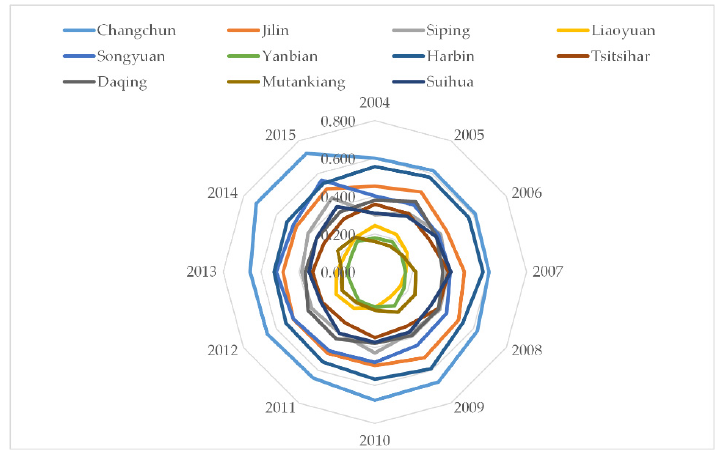
Figure 5. The LCCC of the cities in the HCUA during 2004–2015. Table 4. Classification standards of the LCCC in the HCUA.